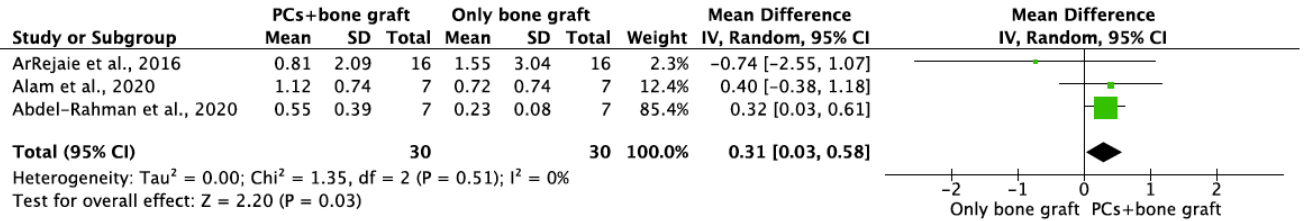
Figure 5. Random-effect meta-analysis evaluating MBL in both aspects at 12 months in immediate implants procedures with PCs + bone graft vs. only bone graft.